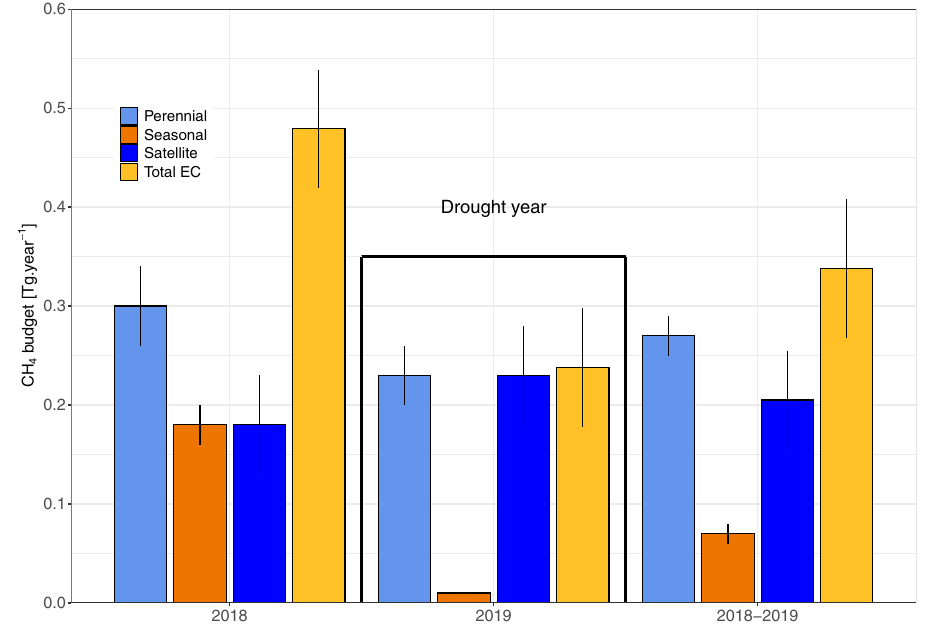
Fig. 5 Annual CH 4 emission budgets by ecohydrological zones and for the entire Okavango Delta. The budgets were obtained from upscaled eddy- covariance (EC) measurements and satellite observations. Total EC budgets are broken down into annual emissions from two hydrological zones (perennial and seasonal wetlands). The budgets for the occasionally fl ooded areas were negligible and were therefore left out. Individual budgets were constructed by summing the monthly emission estimates ( n = 12) for each year. The error bars represent the uncertainty range for the respective emissions budgets; these were calculated by summing monthly uncertainties in quadrature ( n = 12, see Methods and Eq.